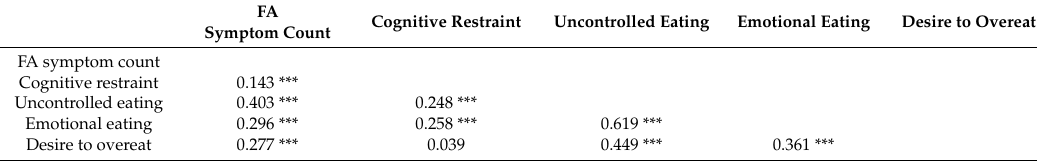
Table 7. Spearman’s rank correlation coefficients among the J-YFAS 2.0-diagnosed food addiction (FA) symptom count, the 18-item Three-Factor Eating Questionnaire (TFEQ R-18) scores, and frequency of desiring to overeat ( n = 731). FA Cognitive Restraint Uncontrolled Eating Emotional Eating Desire to Overeat Symptom Count FA symptom count Cognitive restraint 0.143 *** Uncontrolled eating 0.403 *** 0.248 *** Emotional eating 0.296 *** 0.258 *** 0.619 *** Desire to overeat 0.277 *** 0.039 0.449 *** 0.361